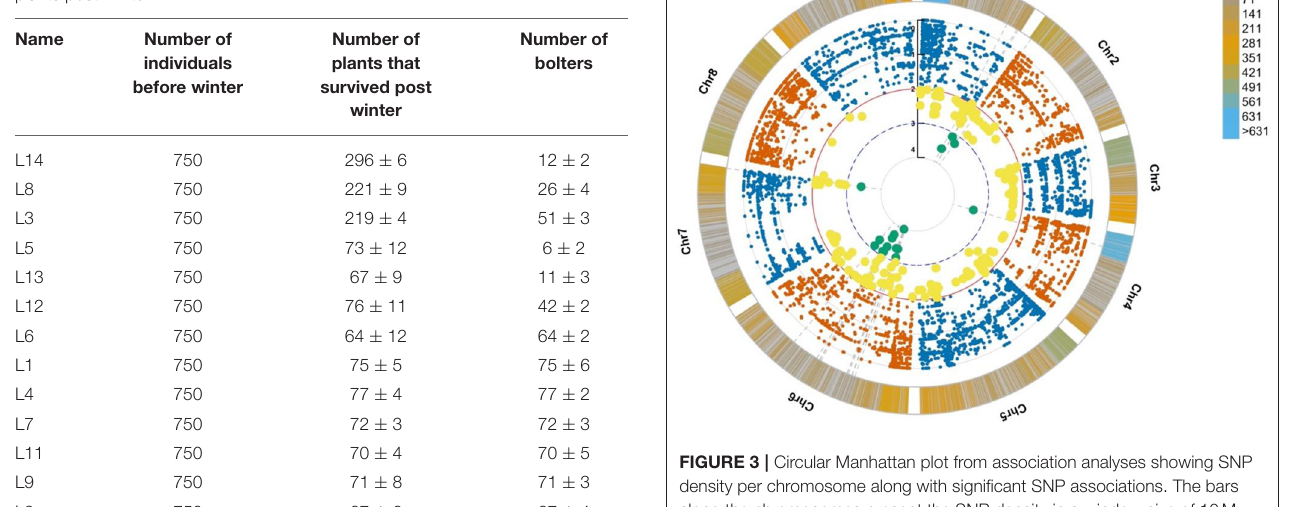
TABLE 1 | Mean values (and standard error) from the phenotyping of 13 sugar beet lines assessed for the number of bolting plants and the number of survived plants post-winter.